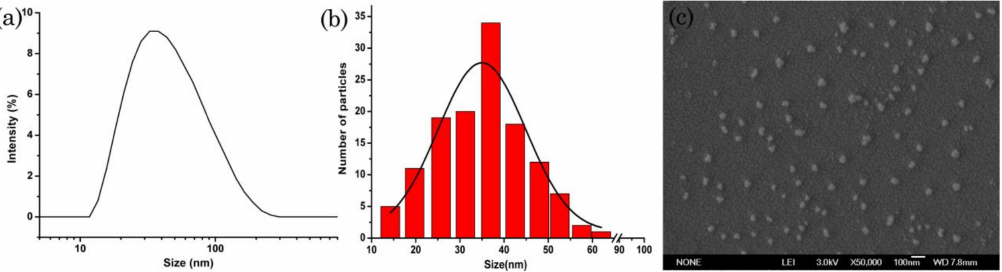
Figure 8. DLS and SEM characterization of the nanosuspension at 54 ◦ C for 14 days: ( a ) Particle size distribution based on DLS; ( b ) Particle size distribution based on SEM image; ( c ) SEM image of the lambda-cyhalothrin nanoparticles.